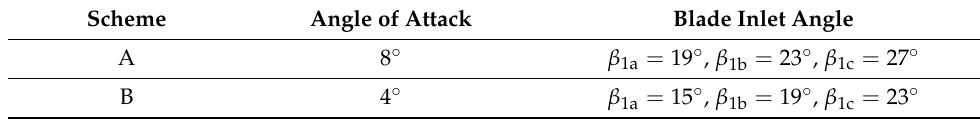
Figure 1. The diagram of velocity triangle at the blade inlet. After calculation, the final result is β (cid:48) Table 2. Design scheme of the blade inlet angle of a double-suction centrifugal pump. Scheme Angle of